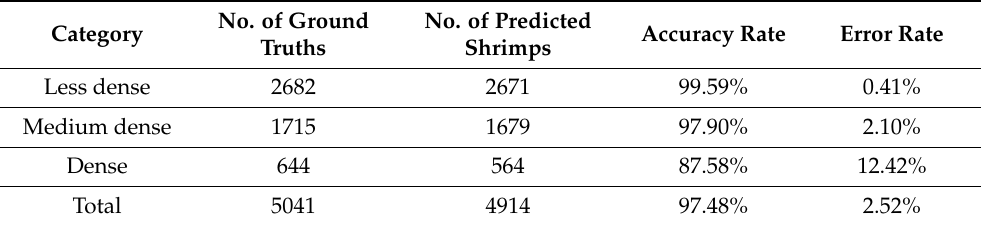
Table 7. Results of accuracy rate and error rate based on category.